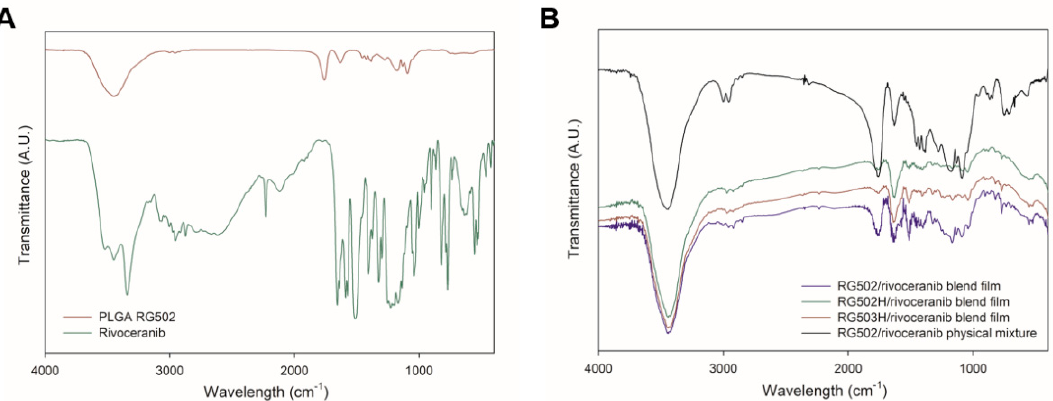
Figure 4. Fourier transform infrared (FTIR) spectrum of ( A ) PLGA RG502 polymer and rivoceranib; ( B ) PLGA RG502 and rivoceranib (1:1) blend film, PLGA RG502H and rivoceranib (1:1) blend film, PLGA RG503H and rivoceranib (1:1) blend film, and physical mixture (1:1) of PLGA RG502 and rivoceranib.